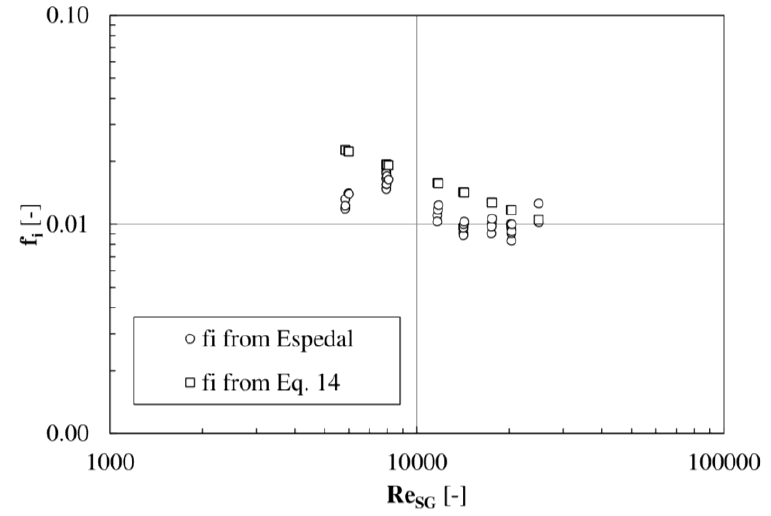
Figure 14. Interfacial friction factor vs. superficial gas Reynolds number for Espedal dataset at ϑ = − 0.5 ◦ .